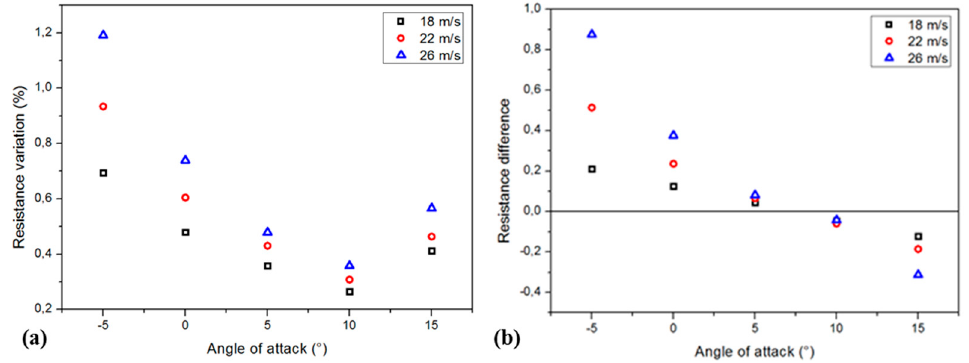
Figure 4. ( a ) Resistance variation of the central wire versus AOA ( b ) Difference of resistance of the lateral wires versus